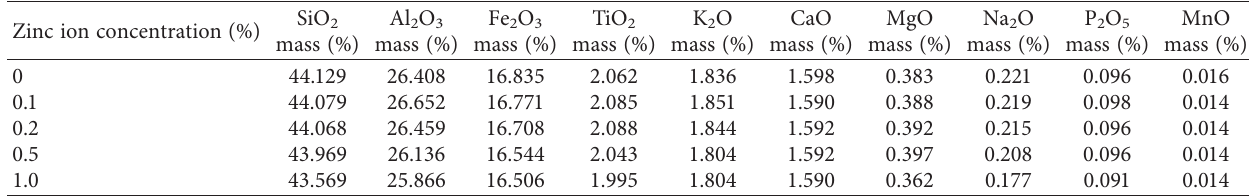
Table 4: Oxide content of the soil sample.